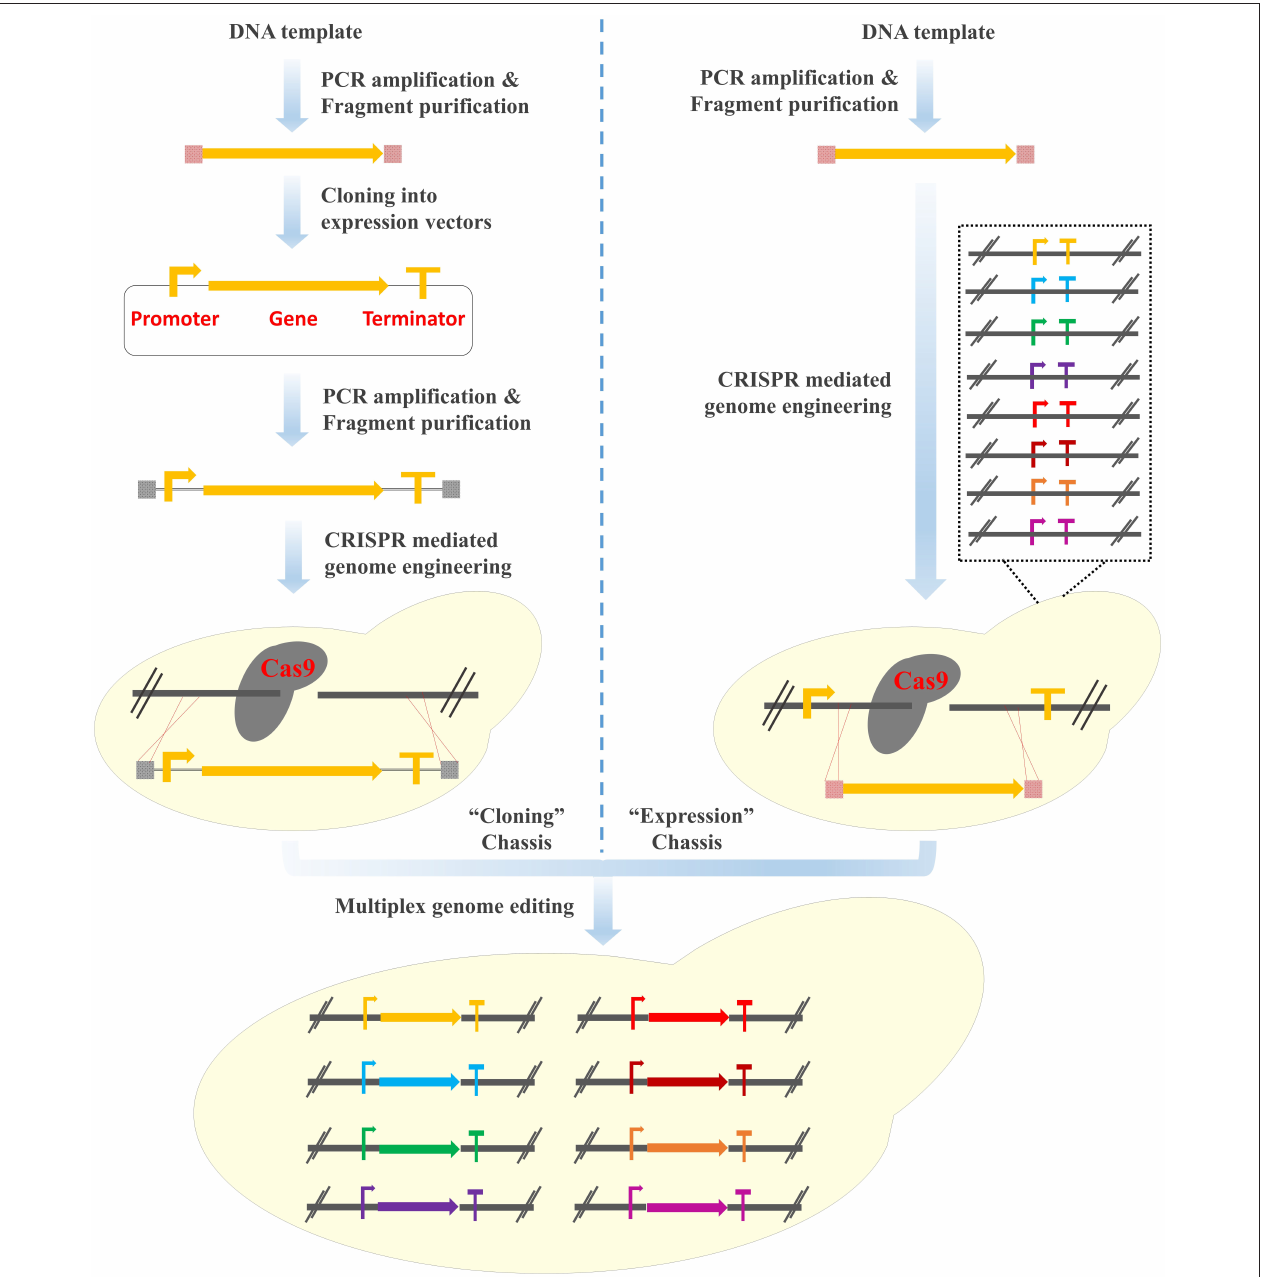
FIGURE 1 | Design of the “PCR & Go” system for the integration of multi-gene pathways in S. cerevisiae . (Left panel) Multiplex genome integration using the CRISPR/Cas9 system. Tedious process of plasmid construction is generally required. (Right panel) Multiplex genome integration using the “PCR & Go” system. PCR amplified gene fragments are integrated into the expression chassis